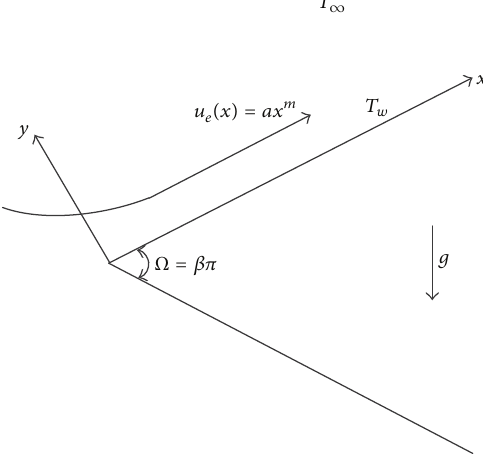
Figure 1: The schematic diagram of the